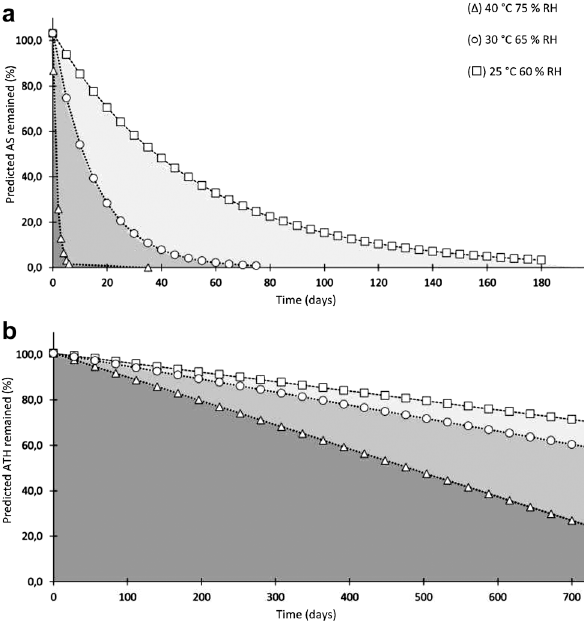
Figure 4: Predicted degradation profile with the best fitted kinetics models of AS (Figure 4A) and ATH (Figure 4B). Modeling was performed at common ICH climatic conditions: ( □ ) 25 ° C / 60% RH ( ○ ) 30 ° C / 65% RH; and ( Δ ) 40 ° C / 75% RH. The shade of grey depends on the intensity of the environmental constraints. If the environmental stocking conditions of the dosage forms are greater than 40 ° C / 75% RH, the predicted degradation pro fi le will be in the darkest grey zone. If the constraints are between 40 ° C 75% RH and 30 ° C / 65% RH, the degradations pro fi les will be in the middle grey zone. If the constraints are between 30 ° C / 65% RH and 25 ° C / 60% RH, the degradations pro fi les will be in the light grey zone.